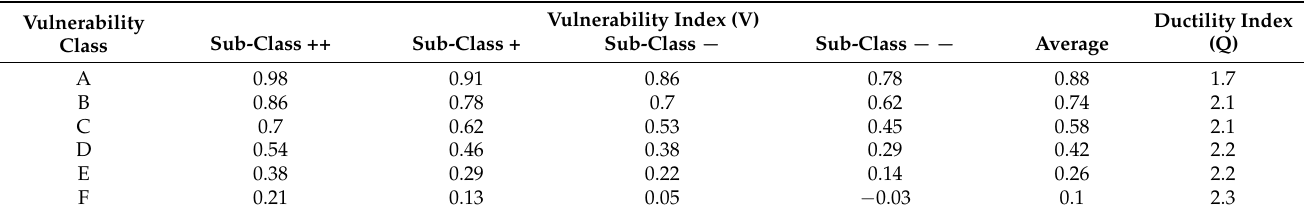
Table 5. Vulnerability and ductility index for each vulnerability class and